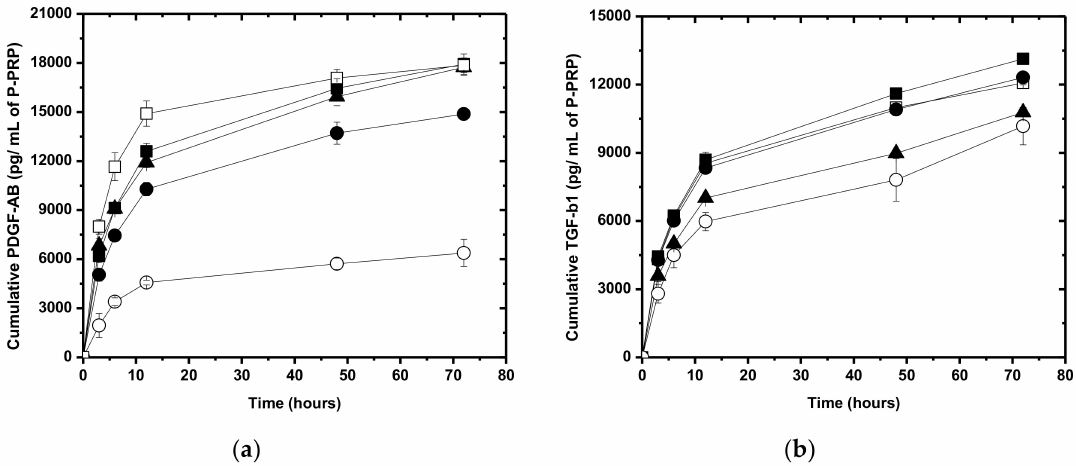
Figure 4. Growth factor release profile from A P-PRP / MP AHA and A P-PRP / MP AHA-CHT. ( a ) PDGF-AB and ( b ) TGF- β 1. (